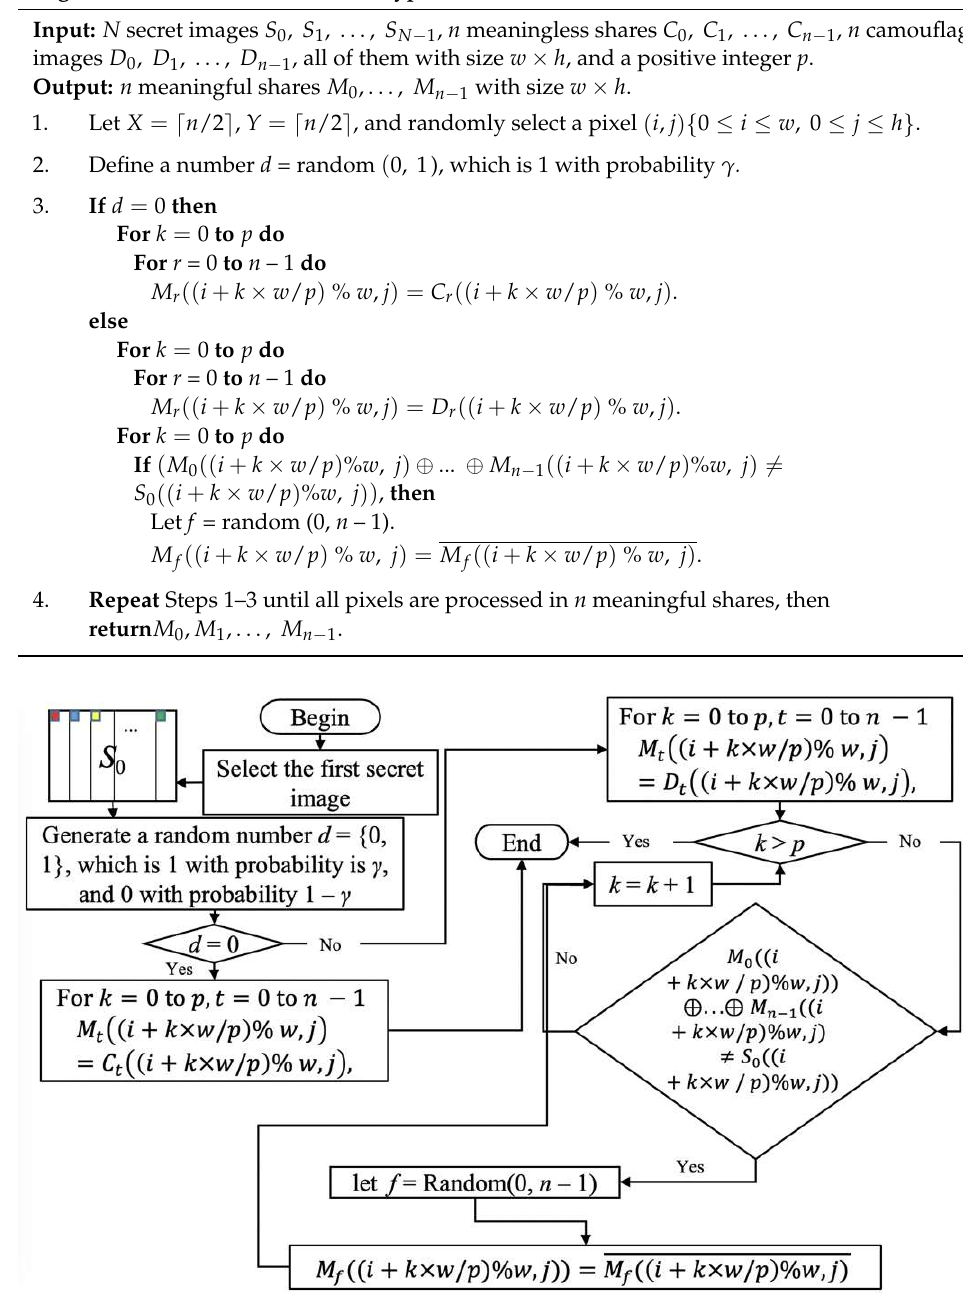
Algorithm 5. [Method 3] Favor encryption